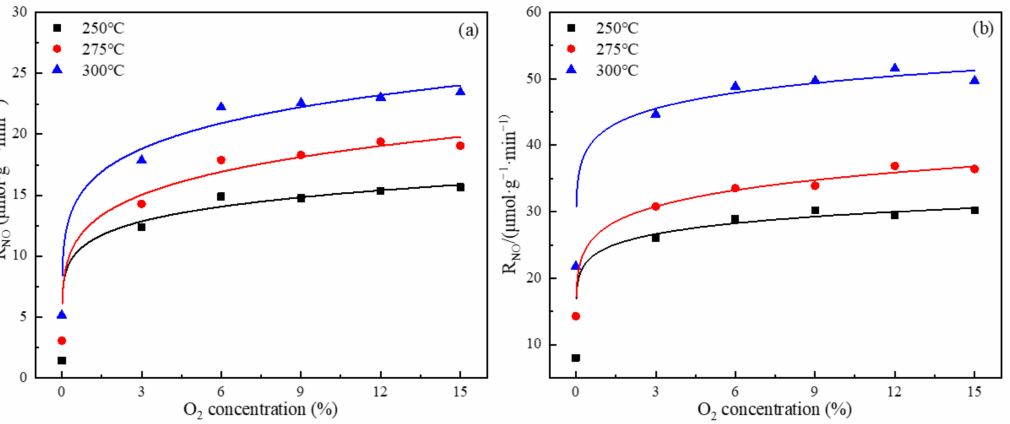
Figure 5. Effect of O 2 concentration on rate of NO conversion: ( a ) SOC, W/F = 0.9 kg · s · L − 1